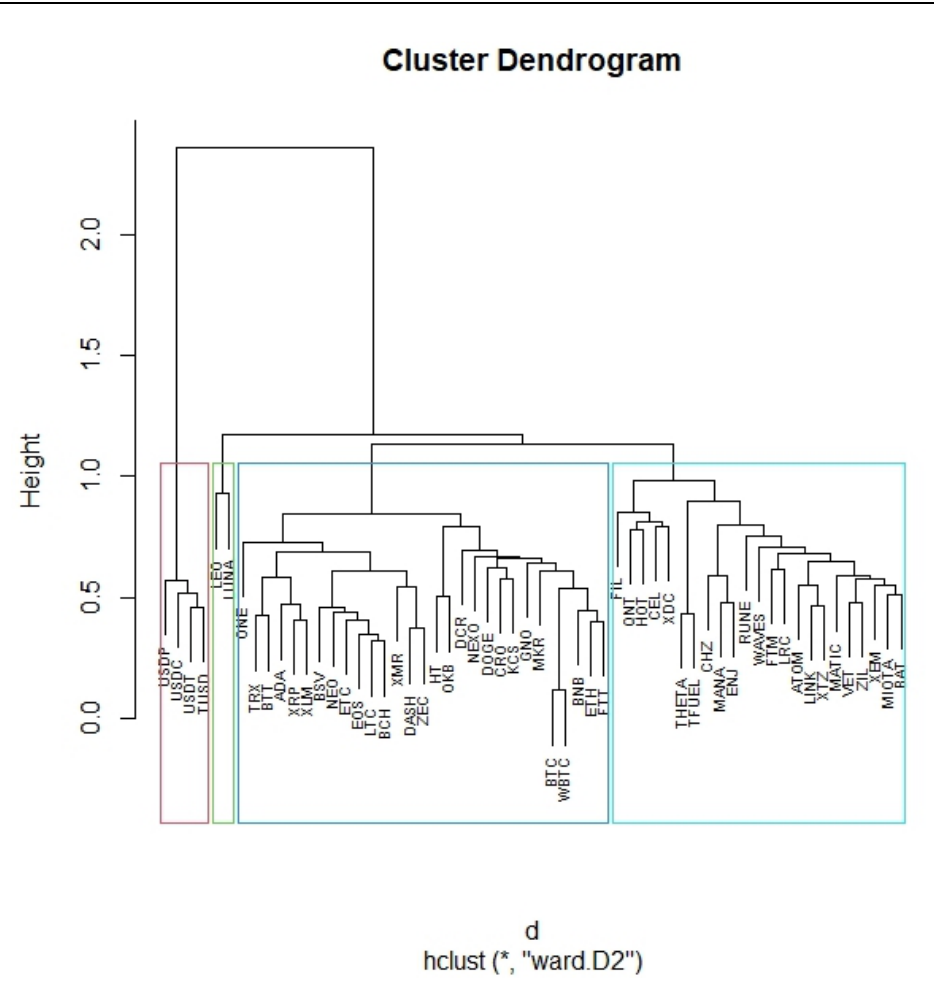
Figure 4. Dendrogram of the